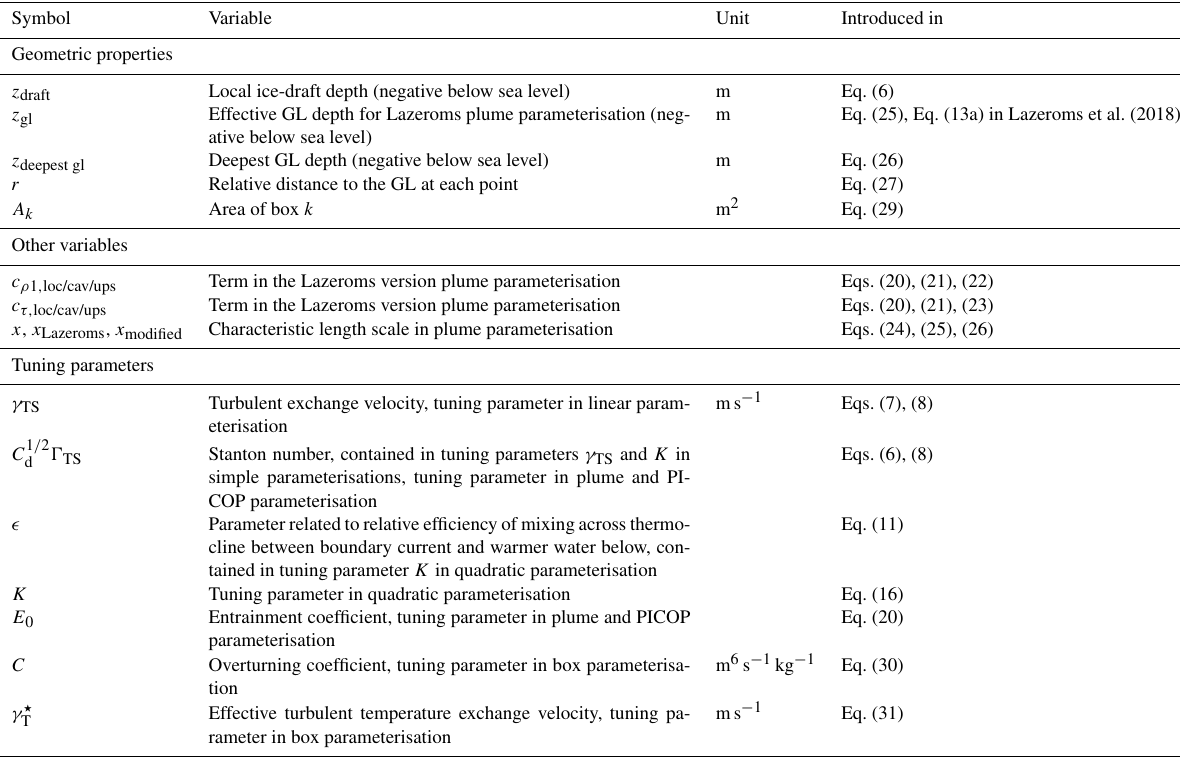
Table C2. Summary of additional variables used in the description of the melt parameterisations in Sect. 2.2. GL stands for grounding line; IF stands for ice